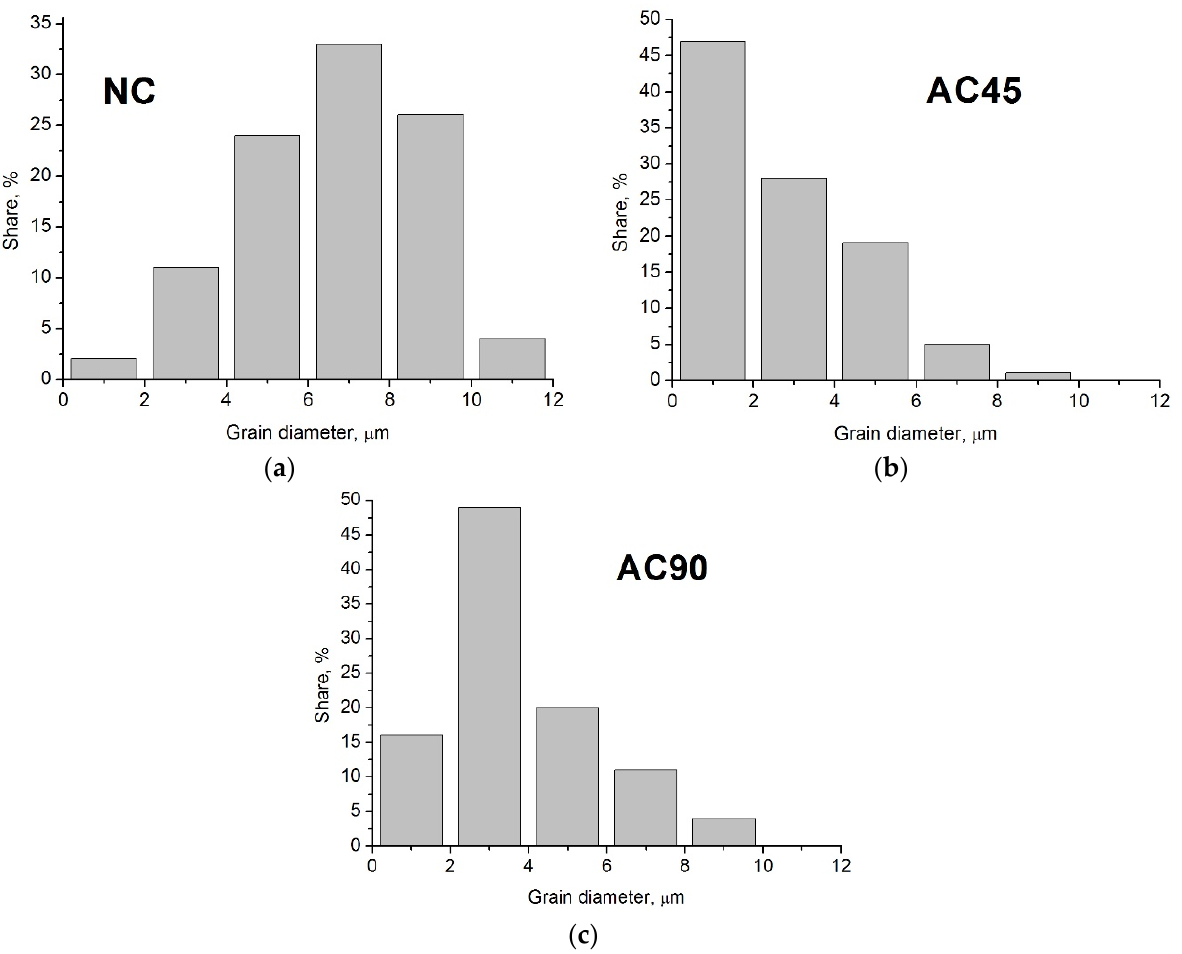
Figure 12. Grain size distributions in NC sample ( a ), AC45 sample (b ), AC90 sample ( c ).